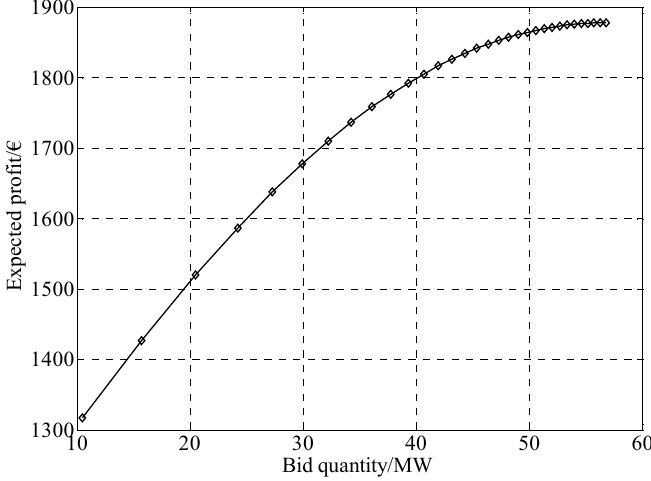
Figure 6. Expected profit versus bid quantity under EPCS with 1 − β = 0.1.